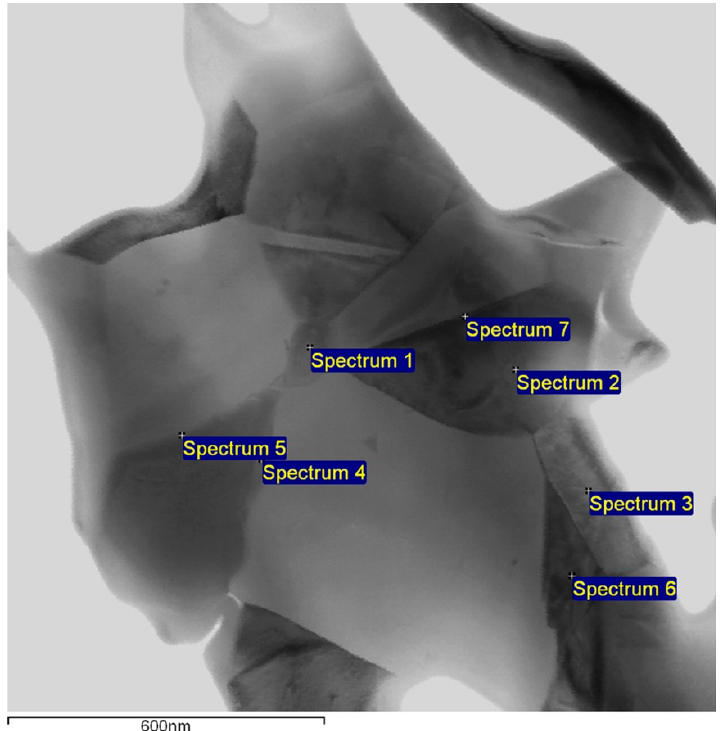
Figure 5. STEM of KZM100-MOD-Y with marked points for energy dispersive X-ray analysis (EDX).